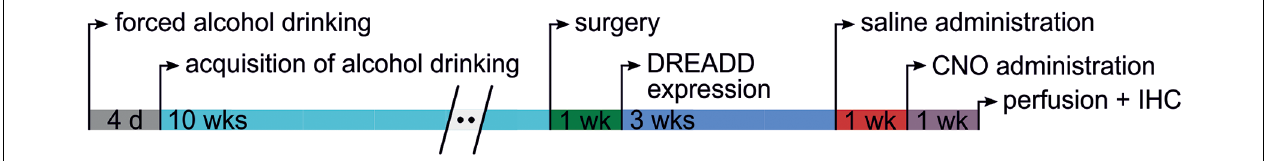
FIGURE 1 | Timeline of the experiments. Shown are the experimental phases and their approximate length each subject was exposed to during the experiments.